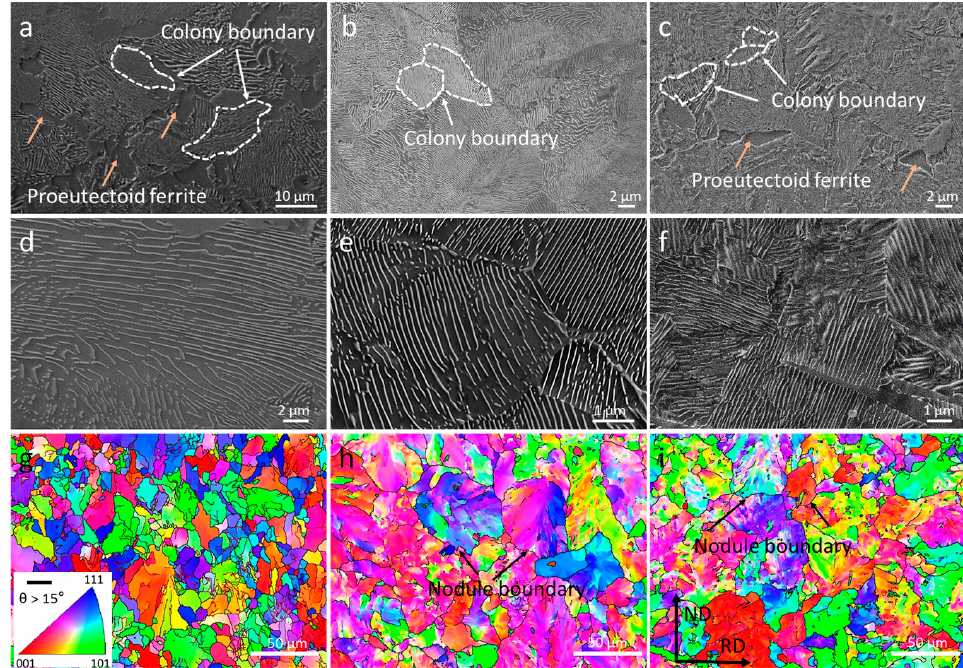
Figure 5. SEM and EBSD micrographs of three hot-rolled strips. ( a – c ) SEM images of CSP-50#, TRC-